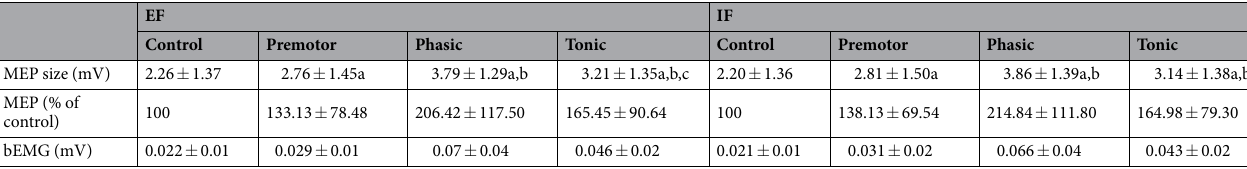
Table 2. Single-pulse TMS in the prime mover (FDI) for all four phases of the movement and the two conditions. Shown are mean values and SD ( n = 12) for single-pulse MEP size, MEP size related to control MEP expressed in percent and the background EMG (bEMG) for both conditions (EF and IF) in the prime mover FDI muscle. Main effect of phase: significant difference ( P < 0.05) for this phase in both conditions compared with control phase (a), compared with the premotor phase (b), and compared with the phasic phase (c). No interaction effect of focus x condition were found in FDI. EF = external focus, IF = internal focus of attention.